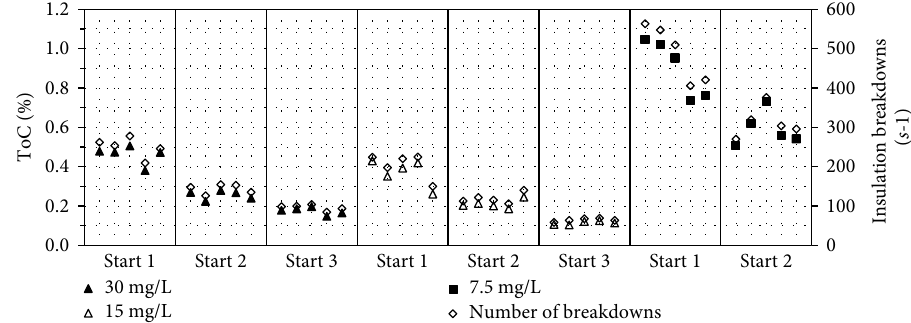
Figure 7: Particle-initiated breakdowns in bearing lubricated Sample A1 mixed with different concentration of Arizona test dust varied at 30 mg/L, 15 mg/L, and 7.5 mg/L.